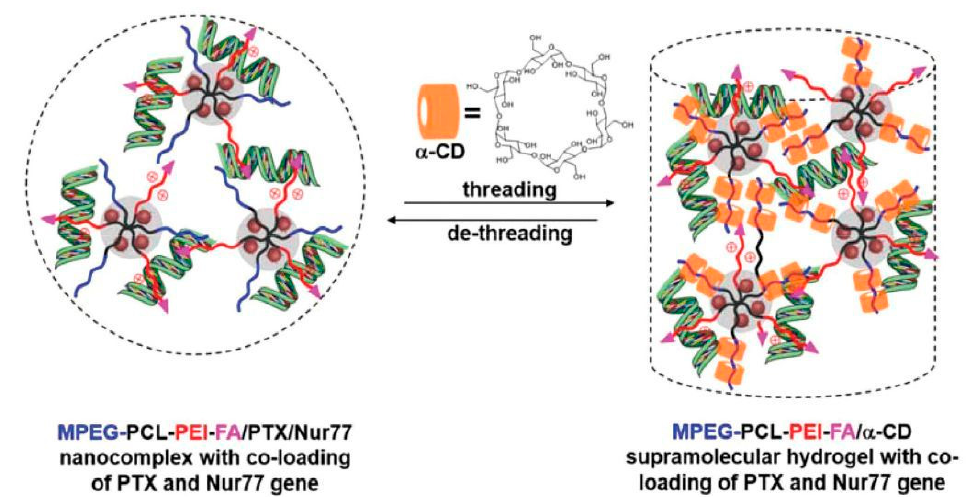
Figure 9. Illustration of the formation of the MPEG-PCL-PEI-FA / α -CD supramolecular hydrogel with co-loading of PTX and the Nur77 gene, which could also be reversed by the de-threading of α -CD in a biological environment, leading to the sustained released of the drug and gene. Adapted with permission from Macromol. Rapid Commun . 2019 , 40 , 1800117 [170]. Copyright (2018) WILEY-VCH Verlag GmbH & Co. KGaA, Weinheim.